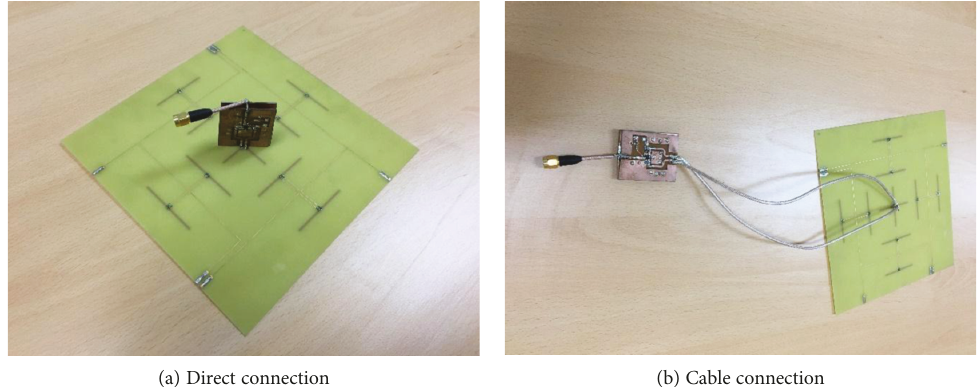
Figure 10: Photographs of the integrated beam steering system with two alternative assembly techniques.